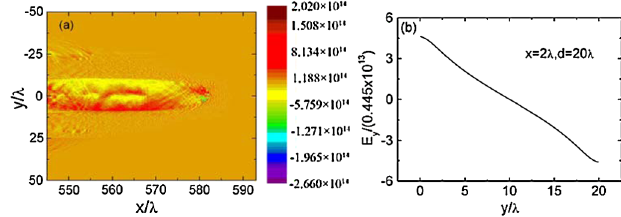
FIG. 4. (Color) (a) Simulation results at t ¼ 600 T for the elec- trostatic field E y for the case of a p -polarized laser pulse under the same conditions as that in Figs. 1–3. (b) Analytical result for the transverse electrostatic field E y (in the moving bubble frame) induced by the fast-moving electrons, for the case of the circu- larly polarized laser considered in Figs.